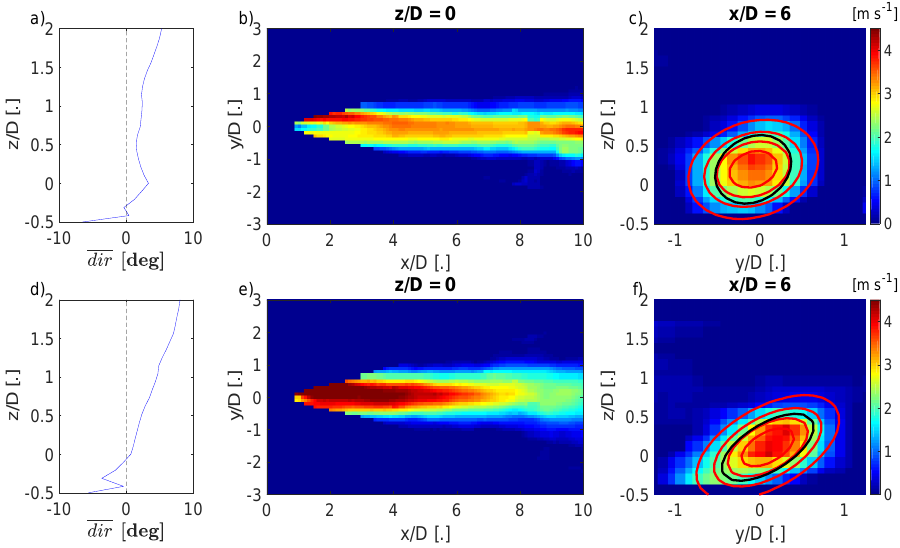
Figure 4. Example cases of volumetric wake measurements for weak wind veer ( a – c ) and strong wind veer ( d – f ). The left column ( a , d ) shows the wind direction profile of the inflow, the middle colum ( b , e ) a horizontal cross section of the longitudinal velocity deficit at z / D = 0, and the right column ( c , f ) a vertical cross section of the longitudinal velocity at a distance of x / D = 6. The red lines in vertical cross section show contours of the 2D-Gaussian fit (Equation (7)) and the black line a contour line of the prediction by the wake model (Equation